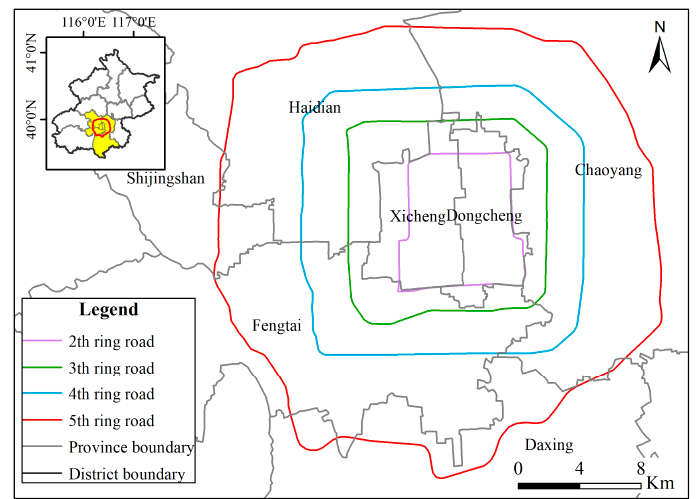
Figure 1. Location of the study area in Beijing.